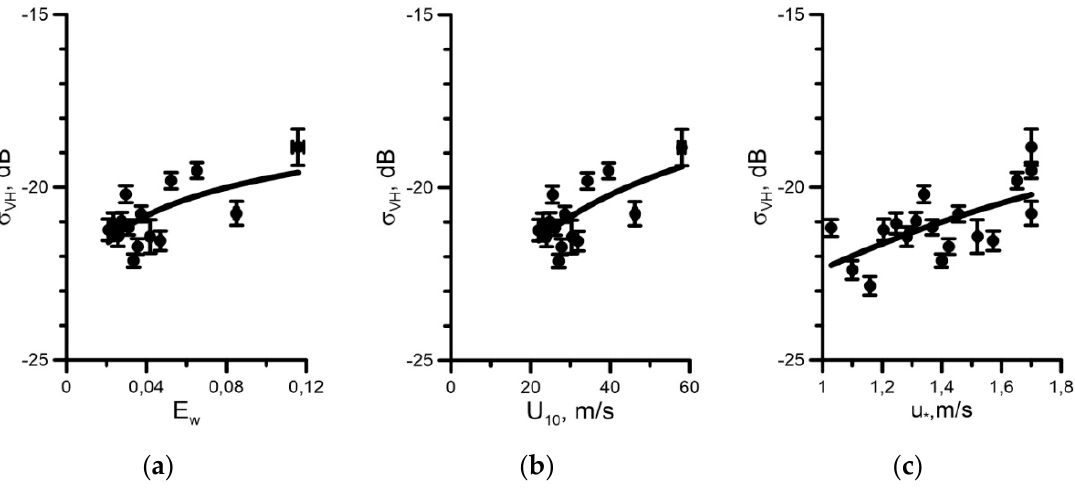
Figure 8. The track of the aircraft over hurricane Irma superimposed on the Sentinel-1 image 2017/09/07.